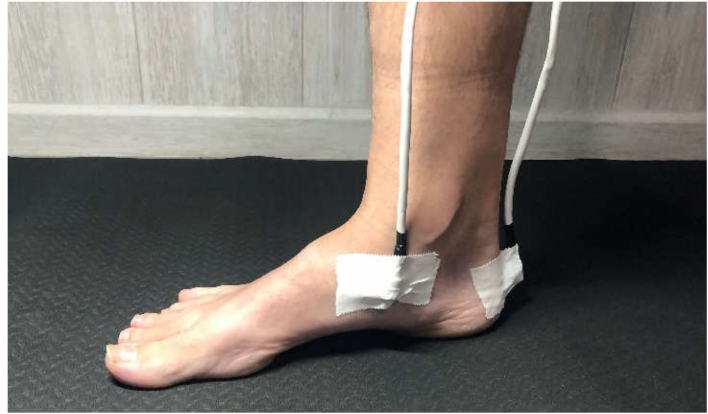
Figure 3. Sensor two. Location placed on the medial navicular